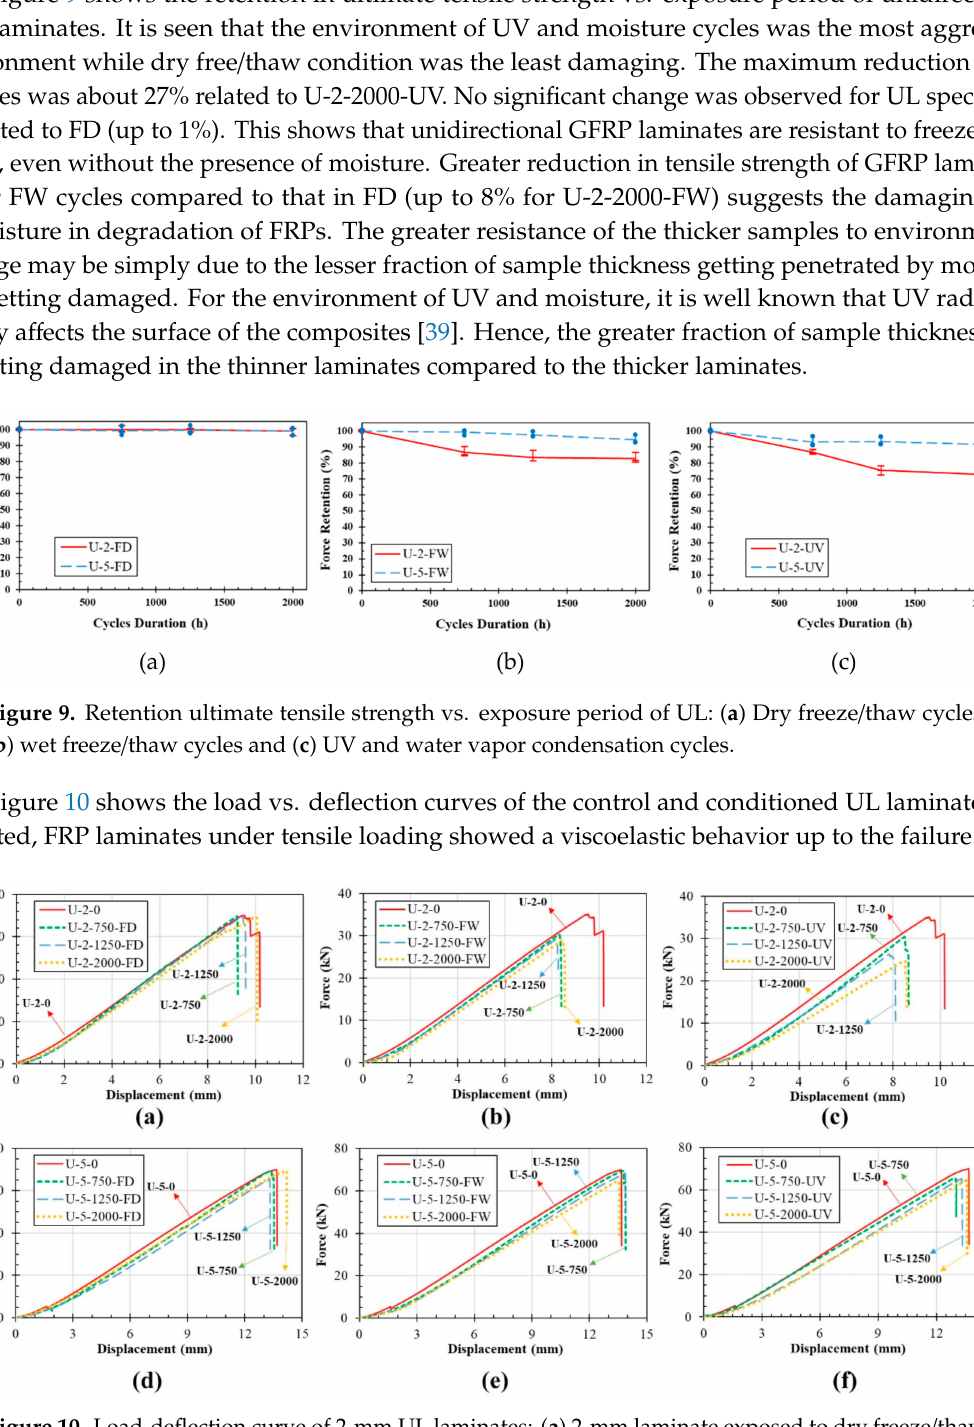
Figure 10. Load-deflection curve of 2-mm UL laminates: ( a ) 2-mm laminate exposed to dry freeze / thaw (FD), ( b ) 2-mm laminate exposed to wet freeze / thaw (FW), ( c ) 2-mm laminate exposed to UV, ( d ) 5-mm laminate exposed to FD, ( e ) 5-mm laminate exposed to FW and ( f ) 5-mm laminate exposed to